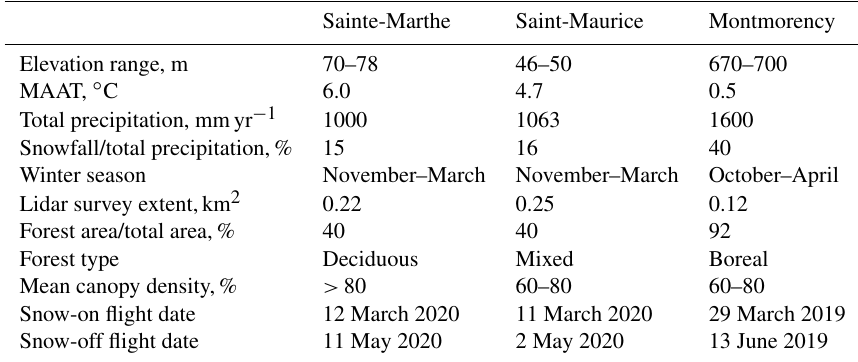
Figure 1. Overview of the study sites with lidar survey extents. Field and forest areas within each lidar extent are delineated with brown and green colors, respectively. (a) Sainte-Marthe, (b) Saint-Maurice, and (c) Montmorency. Contour intervals intentionally differ between sites for better readability (adapted from Dharmadasa et al., 2022). Table 1. Site characteristics and lidar data collection information (adapted from Dharmadasa et al.,